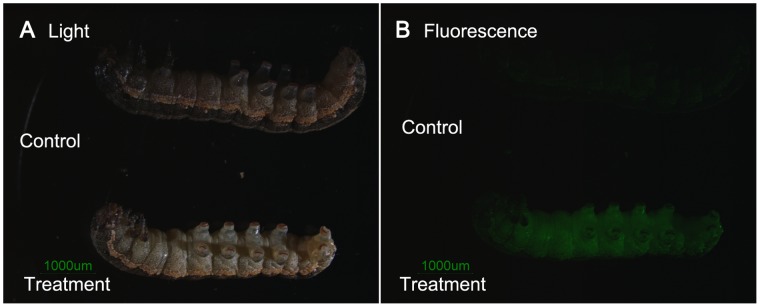
Observation of siRNA spread in the larvae after injection by fluorescent microscopy.Larvae injected with fluorescence labeled chitinase1-siRNA were observed under light (A) and fluorescent microscopy (B), which shows the immediate spread of siRNA to the whole body. The photos were taken five minutes after injection. The controls were un-injected larvae.